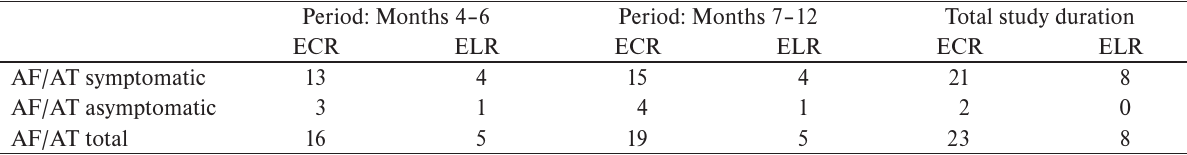
Table 4. Arrhythmia recurrences by monitoring technology.